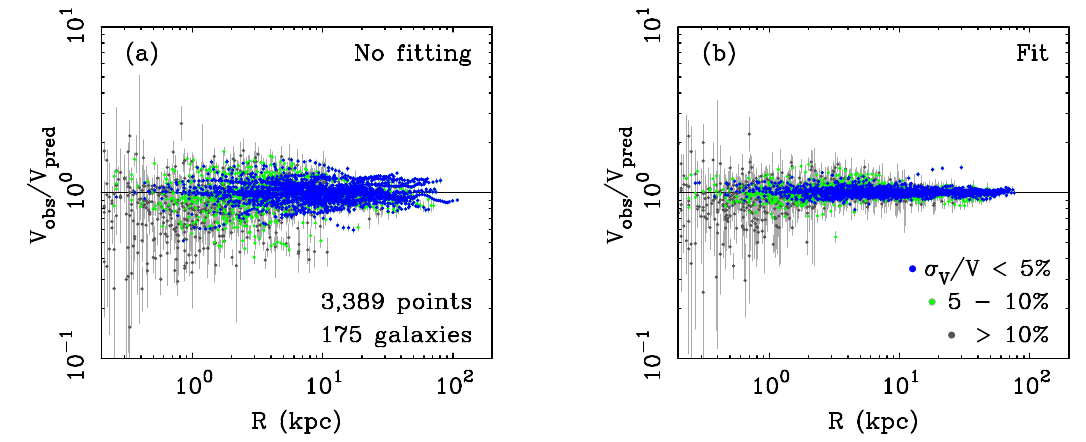
Figure 6. Ratio of the observed velocity to that predicted by MOND, without ( a ) and with ( b ) fitting. All available data for galaxies from the SPARC database [29] are shown. Each point represents one resolved datum along the rotation curves of these galaxies. Points are color coded by measurement accuracy, as noted in the inset. No fitting has been performed in ( a ): the same nominal mass-to-light ratio ([3.6] Υ ∗ = 0.5 M (cid:12) /L (cid:12) for the disk and 0.7 M (cid:12) /L (cid:12) for the bulge) has been adopted for all galaxies to predict the velocity—i.e., the equivalent of the green line in Figure 5a for all SPARC galaxies. This procedure returns the correct velocity to within 0.15 dex for 90% of the data. The small scatter in